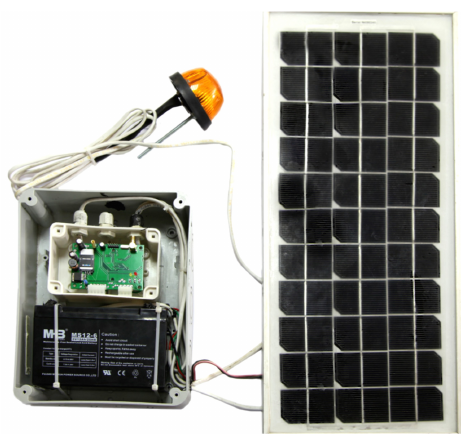
Figure 3. Automated irrigation quality control system Rain-1.